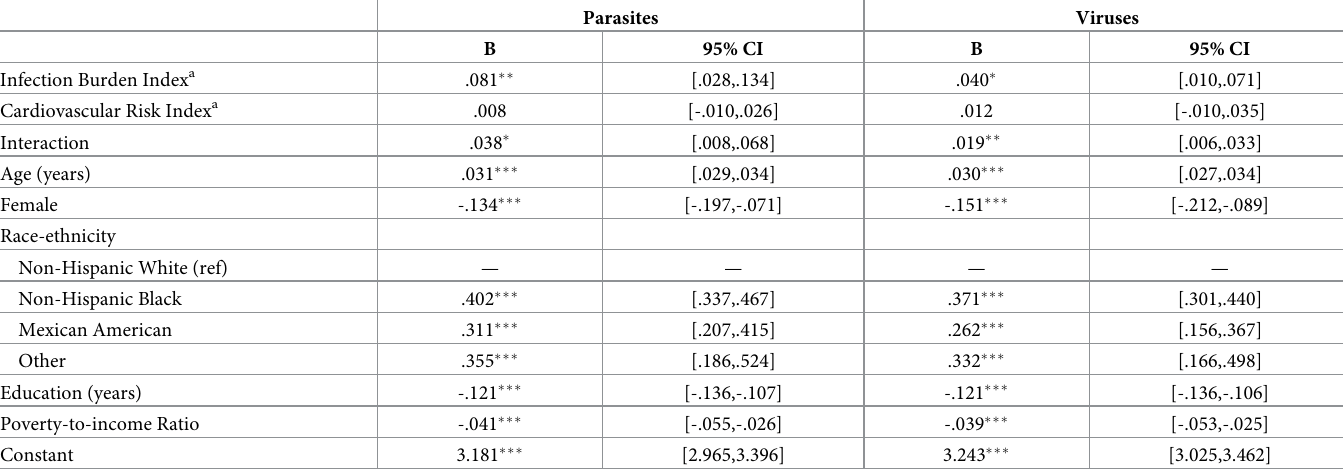
Table 5. Interaction effects of parasite or virus-specific infection-burden indices and a cardiovascular-risk index and association with SDS performance in U.S. adults aged 20 to 59 years